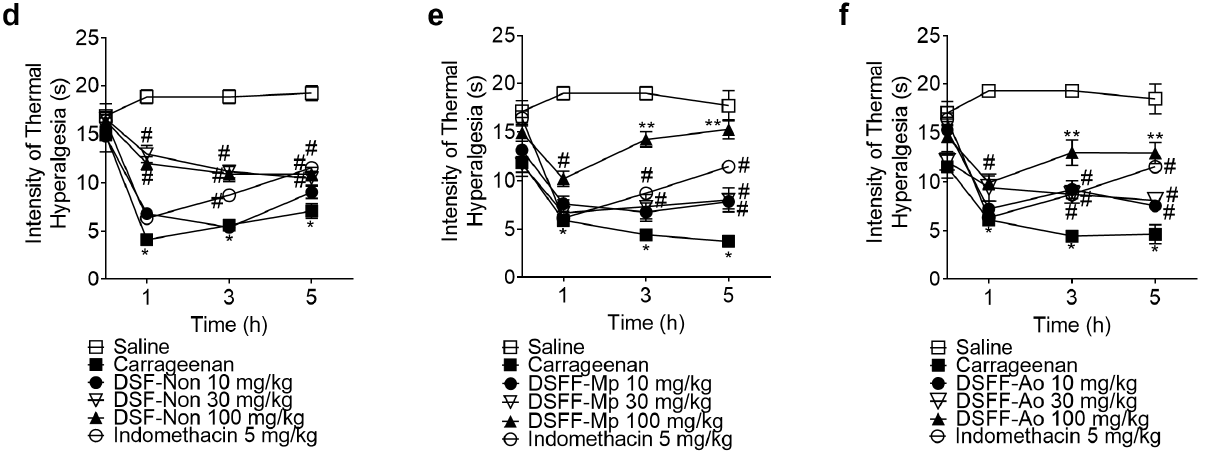
Figure 2. Evaluation of mechanical hyperalgesia and thermal hyperalgesia. Dose-response (10–100 mg/kg) experiment for DSF-Non extract are shown in panels ( a , d ); DSFF-Mp extract in ( b , e ); DSFF-Ao extract in ( c , f ). Indomethacin (5 mg/kg) was used as positive control drug. ( a – c ) Mechanical hyperalgesia and ( d – f ) thermal hyperalgesia were evaluated 1, 3, and 5 h after carrageenan i.pl. injection. Results are expressed as mean ± SEM of six mice per group per experiment and are representative of two independent experiments. * p < 0.05 vs. saline group; # p < 0.05 vs. carrageenan group; ** p < 0.05 vs. carrageenan and other doses.